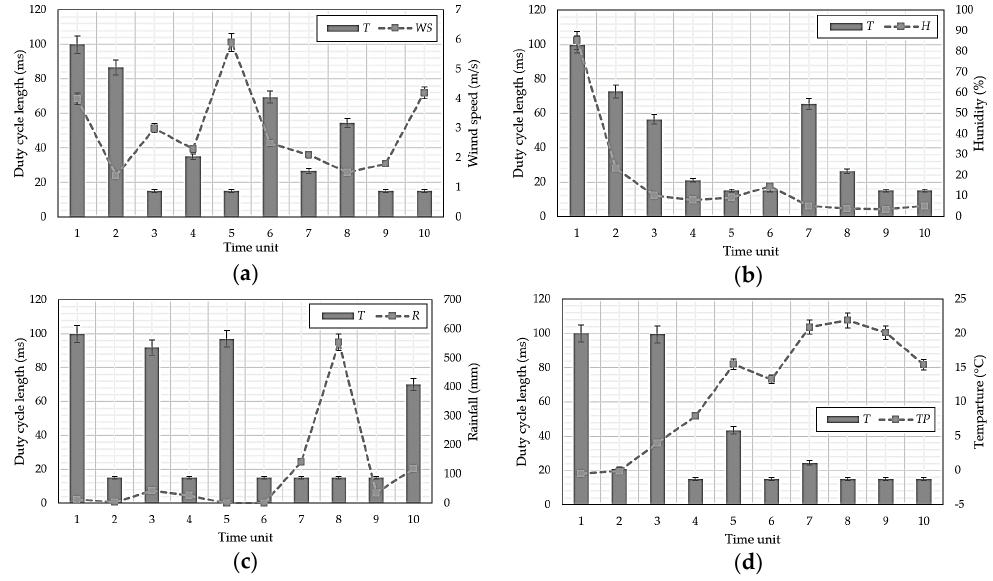
Figure 10. Duty-cycle length, T , changes for climate factor changes ( a ) wind speed; ( b ) humidity; ( c ) rainfall, and ( d ) temperature.